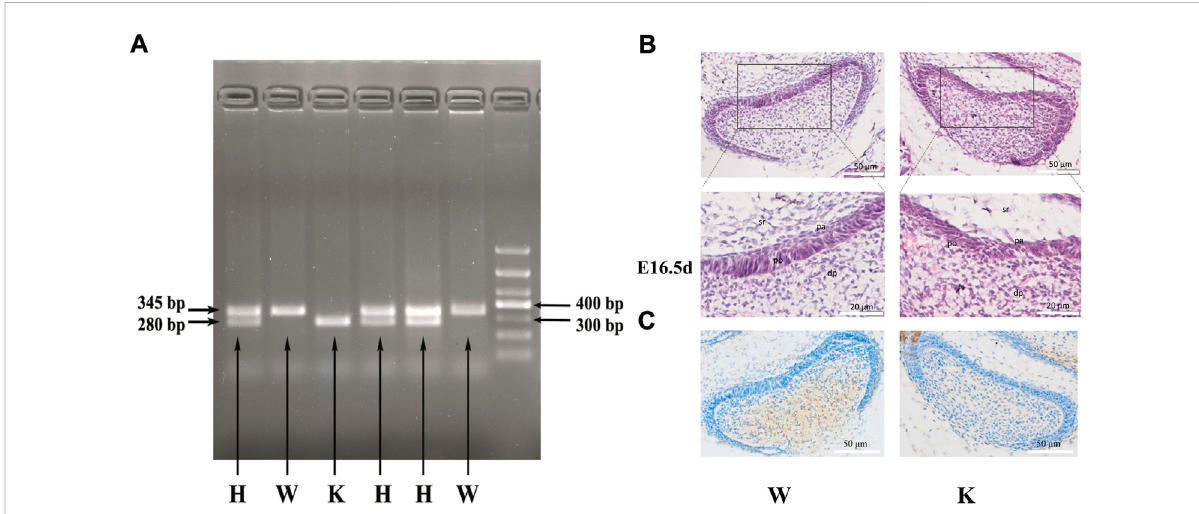
FIGURE 4 The genotype identi fi cation and dental germ morphology of p75NTR knockout mice. Of the six littermates detected, three with two bands of 280 bp and 345 bp were identi fi ed as heterozygous mice, two with one band of 345 bp were identi fi edas wild-type mice, and one with one band